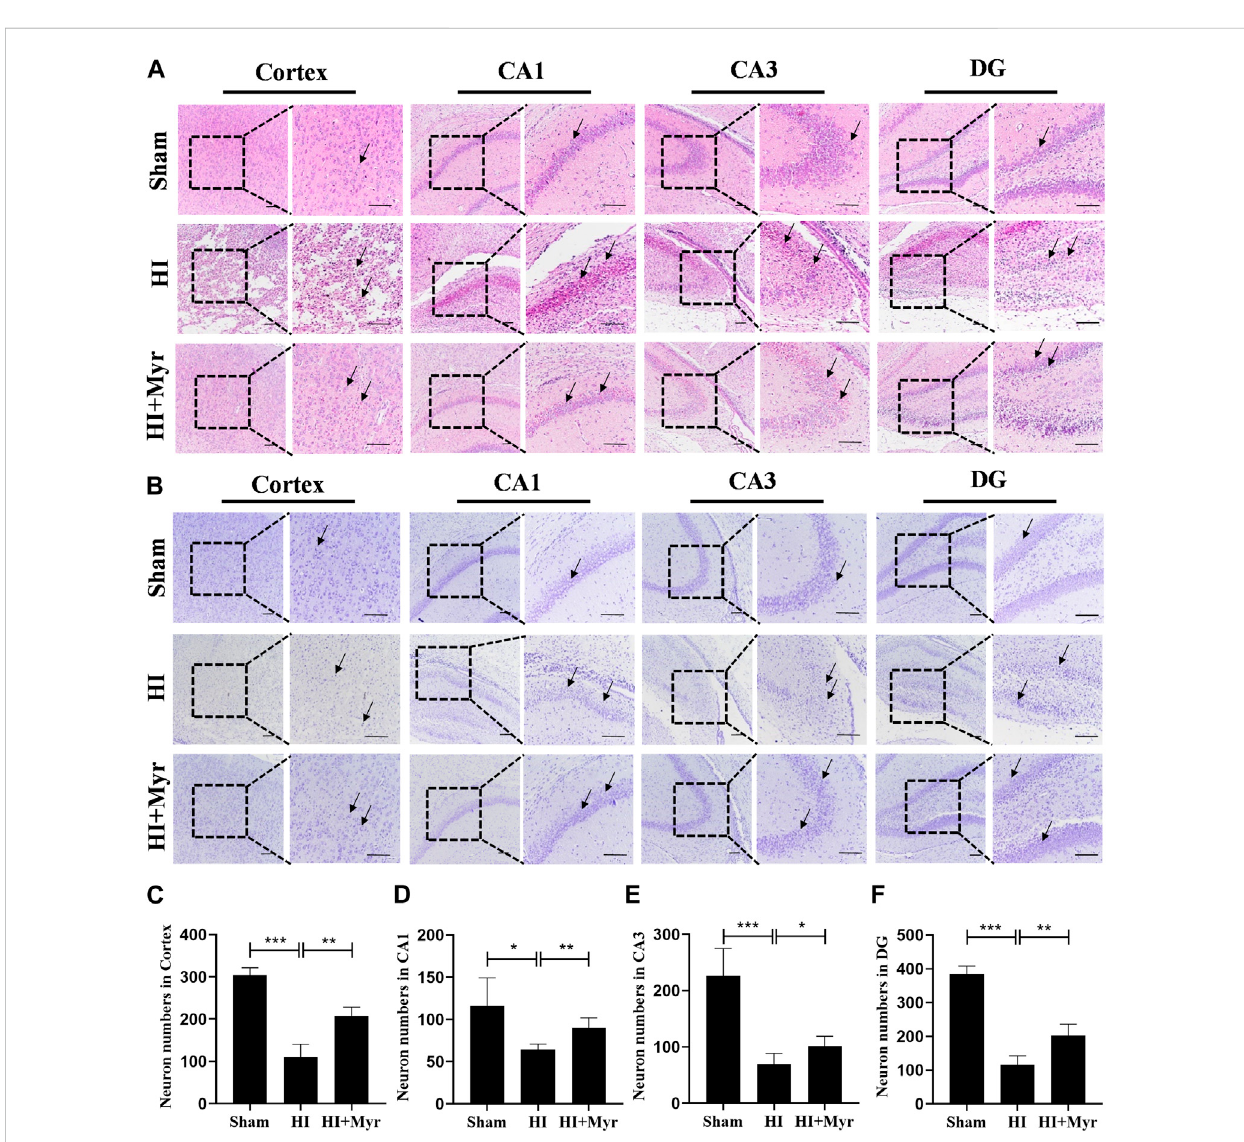
FIGURE 3 Myricetinamelioratedthetissuestructuraldamageandreducedthelossofneurons. (A) TherepresentativeimagesofHEstaininginbraincortexand hippocampal CA1, CA3, DG regions 7 days after HI brain injury. Black arrows: indicate the morphology of brain tissue and cells. (B) The representative images of Nissl staining in brain cortex and hippocampal CA1, CA3, DG regions 7 days after HI brain injury. Black arrows: indicate the Nissl body integrity. (C) Quanti fi cation analysis of neuron numbers in brain cortex ( n = 4 per group). (D) Quanti fi cation analysis of neuron numbers in hippocampal CA1 region ( n = 4 per group). (E) Quanti fi cation analysis of neuron numbers in hippocampal CA3 region ( n = 4 per group). (F) Quanti fi cation analysis of neuronnumbersinhippocampalDGregion( n =4pergroup).Thedataarepresentedasmean±SD.* p < 0.05,** p < 0.01,*** p < 0.001.Scalebar:100 μ